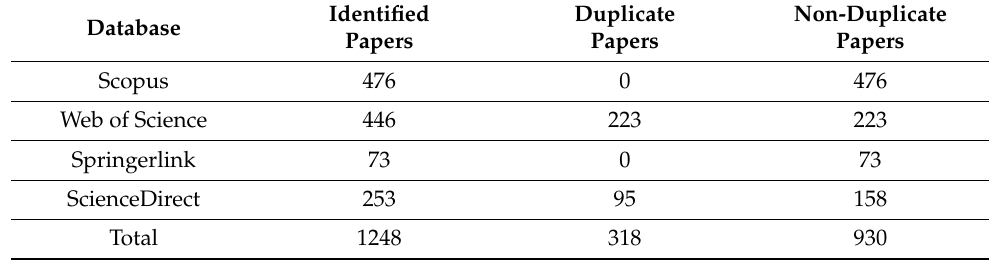
Table 3. Identified papers by database.